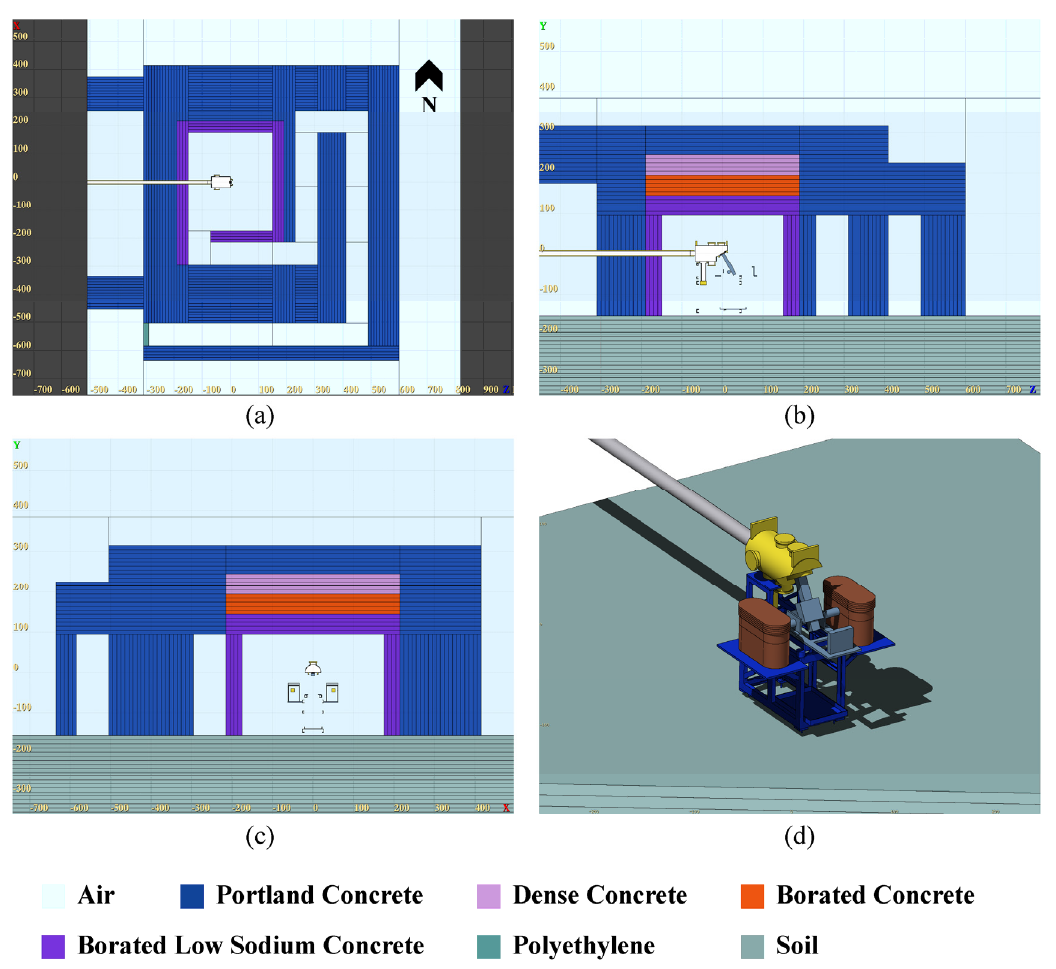
Figure 4. ( a – c ) Cross ‐ sectional view of the experimental terminal geometry. ( d ) Three ‐ dimensional model of the target system in Flair. Distances are given in cm.